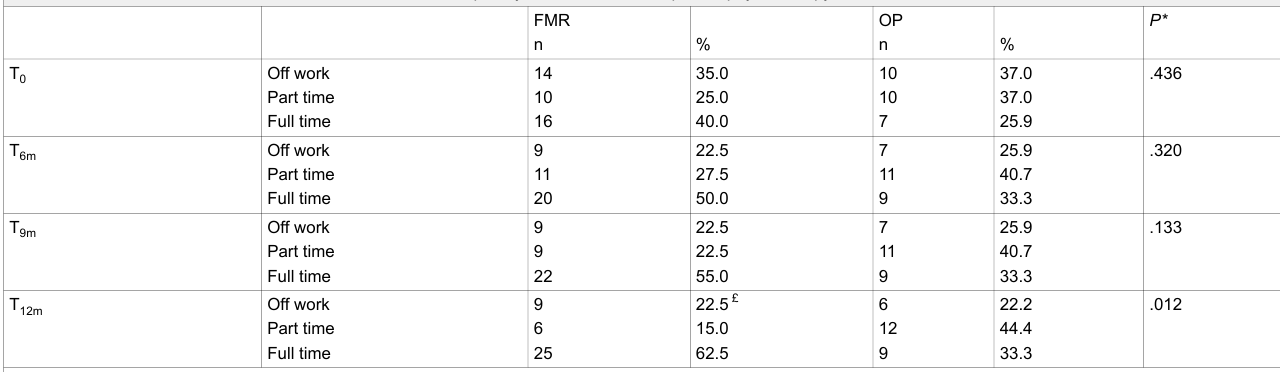
Table 2: Work status at baseline and after functional multidisciplinary rehabilitation or outpatient physiotherapy.